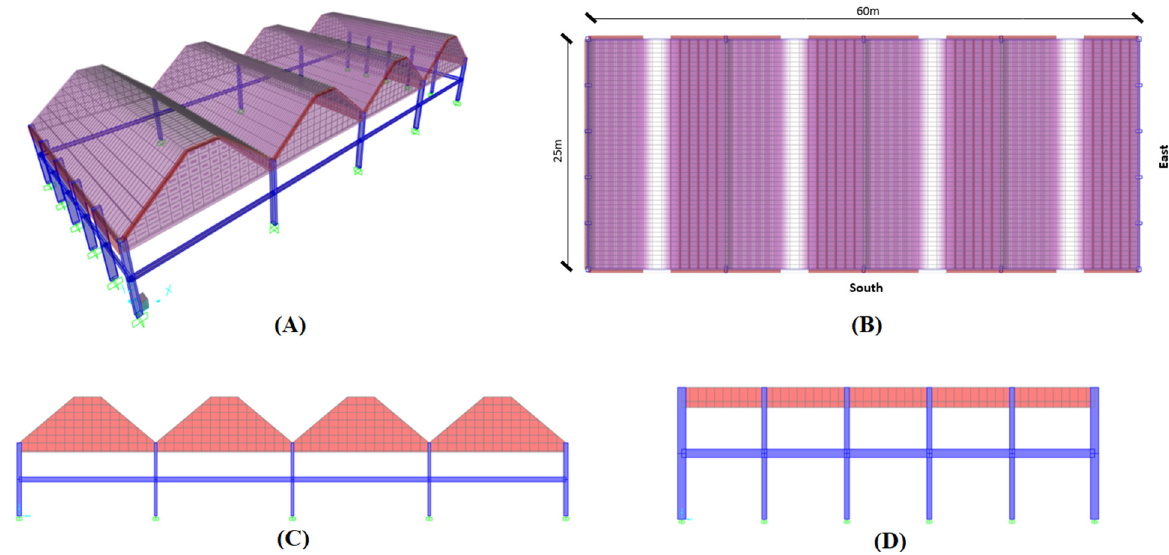
Figure 17. Three-segment type folded plate roof problem: ( A ) 3D view; ( B ) Plan view; ( C ) South elevation view; ( D ) East elevation view. Table 22. Input data for the three-segment type folded plate roof building.